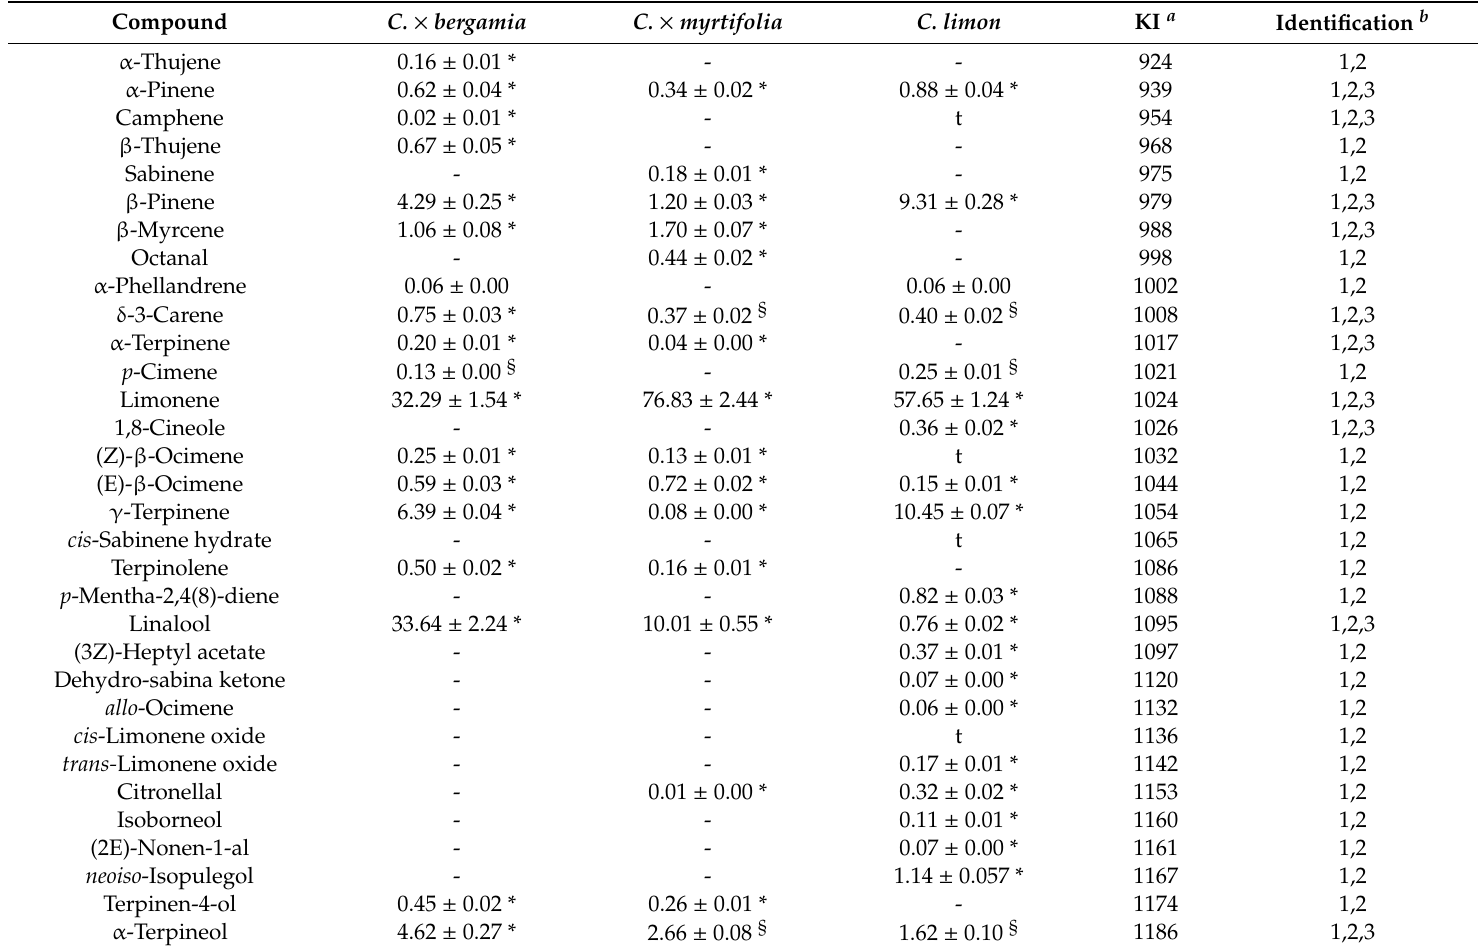
Table 2. Chemical composition of the Citrus essential oils investigated. Results are expressed as mean area percentage (%) ± standard deviation (S.D.) of three independent determinations in triplicate ( n =